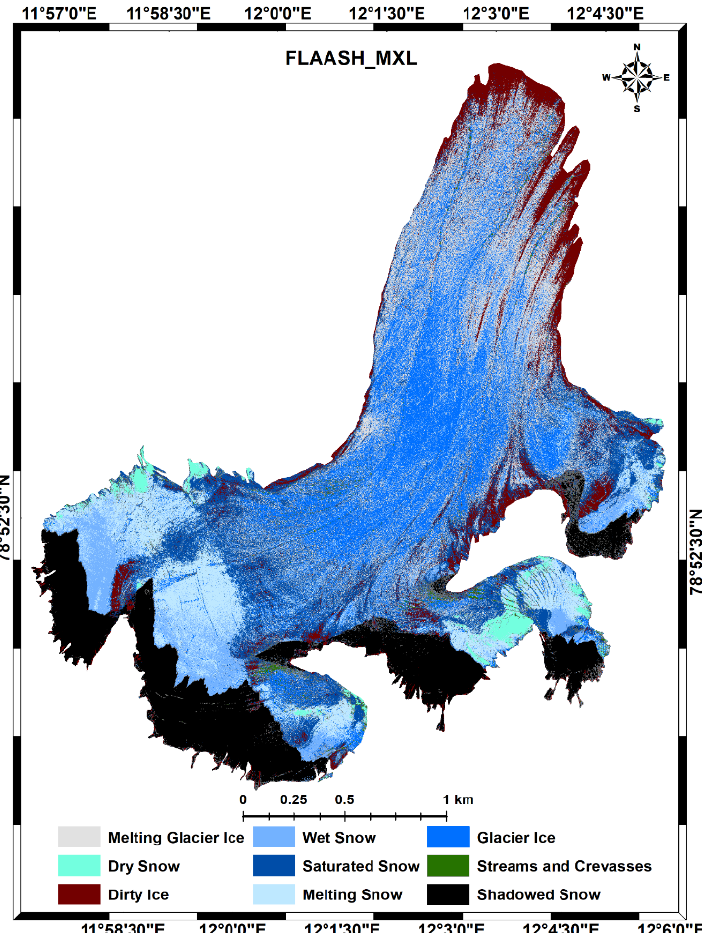
Figure 7. Thematic classification results of the MXL algorithm for the FLAASH atmospheric correction for the ML glacier.